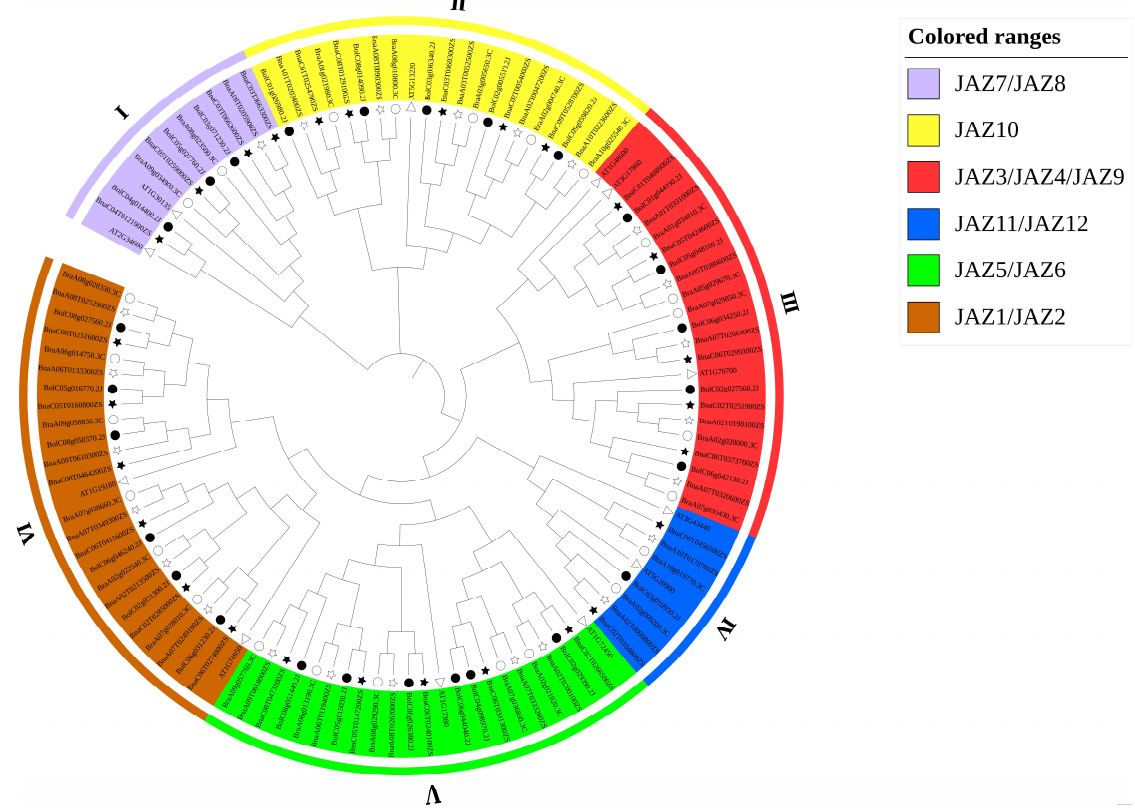
Figure 1. Phylogenetic analysis of 114 JAZ proteins from Arabidopsis , B. napus , B. rapa , and B. oleracea . The JAZ proteins from B. napus (51), B. rapa (25), B. oleracea (26), and Arabidopsis (12) are marked with stars, hollow circles, solid circles, and triangles, respectively. The number of bootstrap values was based on 1000 iterations. The hollow and solid stars represent genes located in the A and C subgenomes in B. napus , respectively. The neighbor-joining (NJ) tree shows six groups marked by Roman numerals and different colors: group I (purple) homologous to AtJAZ7/AtJAZ8, group II (yellow) homologous to AtJAZ10, group III (red) homologous to AtJAZ3/AtJAZ4/AtJAZ9, group IV (blue) homologous to AtJAZ11/AtJAZ12, group V (green) homologous to AtJAZ5/AtJAZ6 and group VI (orange) homologous to